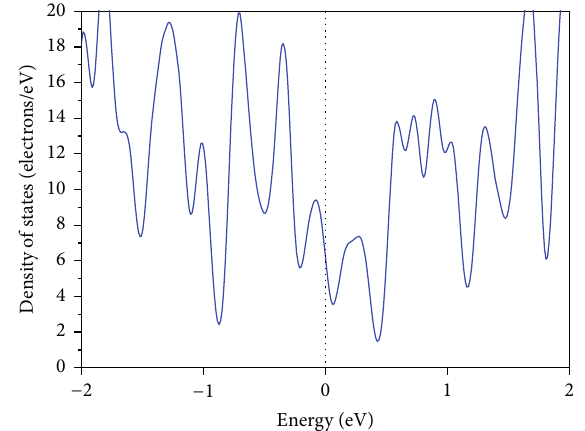
Figure 14: Density of states (DOS) of N2-doped single walled chiral (4,2) BNT. The Fermi energy is set corresponding to zero energy and represented by dotted